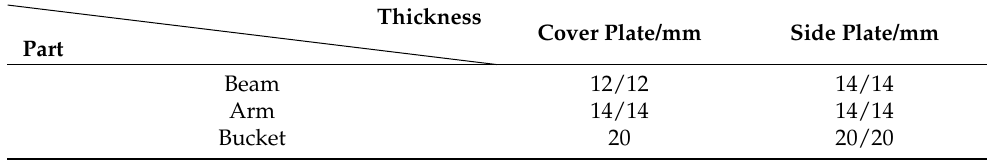
Table 1. The thickness of the steel